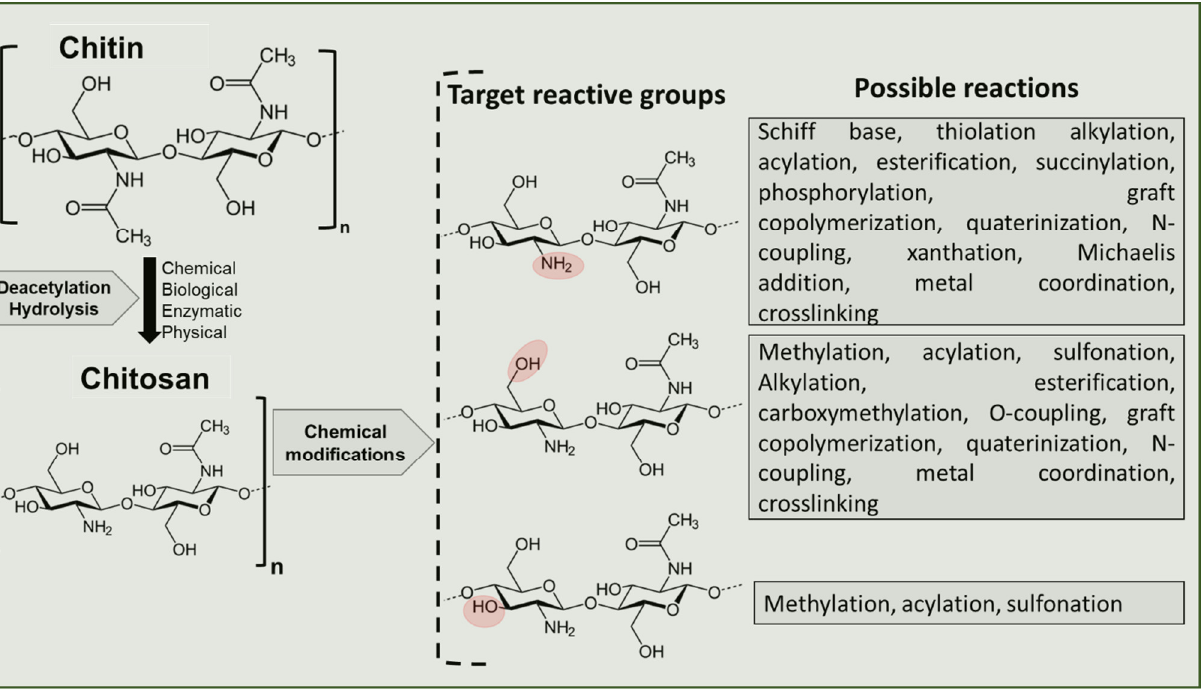
Figure 4. Target functional chitosan molecules (–OH, –NH 2 ) groups for chemical modification. Dual functionalized chitosan hemostatic wound dressings were formulated using varying ratio of quaternized chitosan and phosphorylated chitosan along with tannic acid